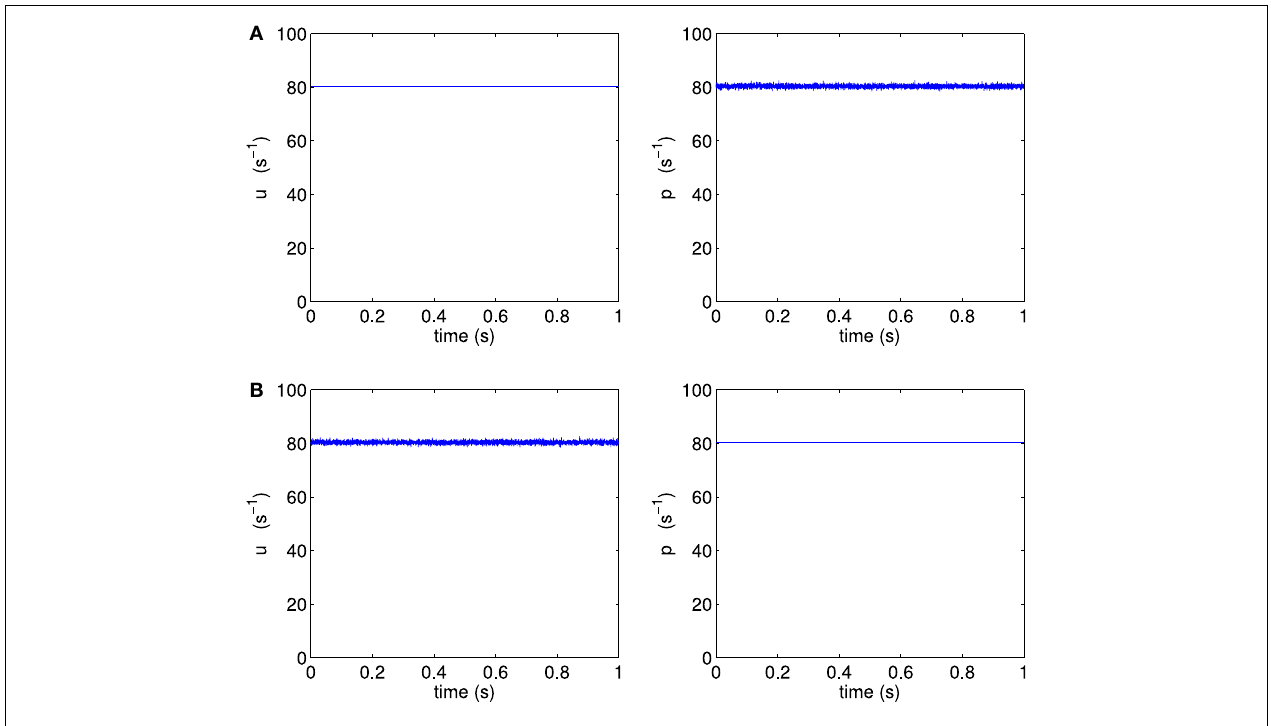
FIGURE 5 | One second of sample external inputs u and p , (A) for scenario H3p and (B) for scenario